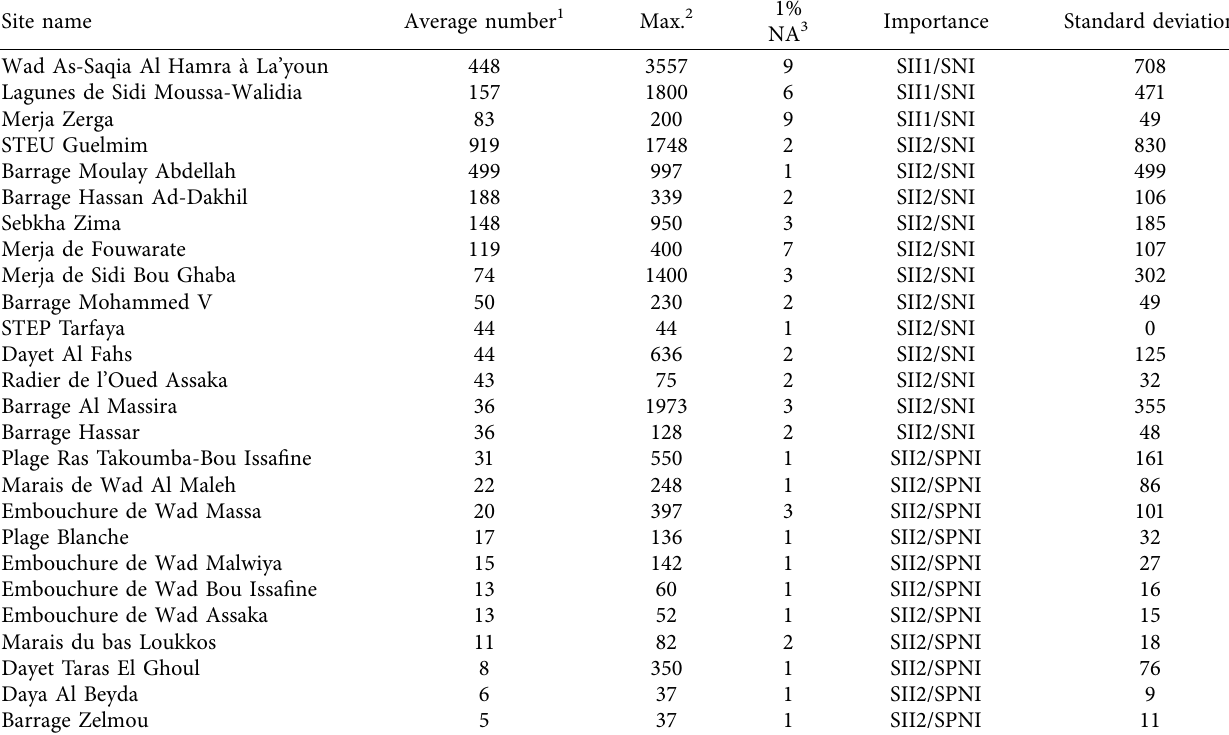
Table 3: Most important wintering sites of the Marbled Teal